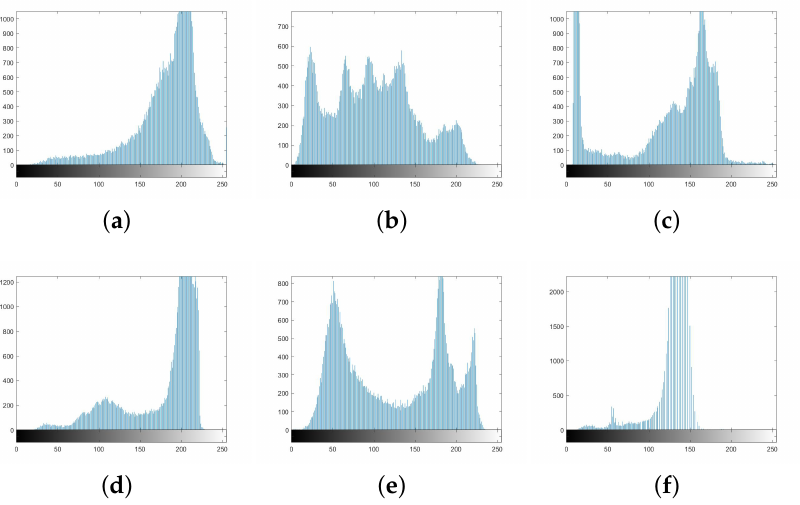
Figure 11. Tonal distribution: histograms of plain standard images: ( a ) aerial; ( b ) lena; ( c ) cameraman; ( d ) jet; ( e ) lake; ( f )